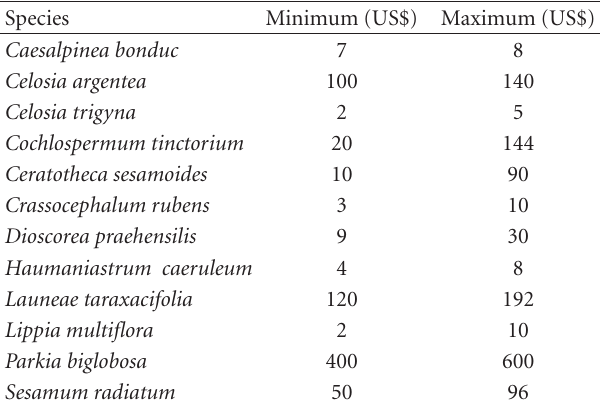
Table 5: Contribution of some species under domestication to household income